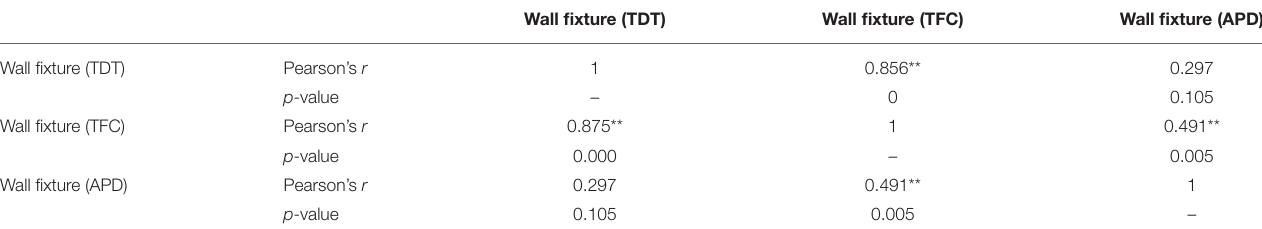
TABLE 4 | Correlation matrix.